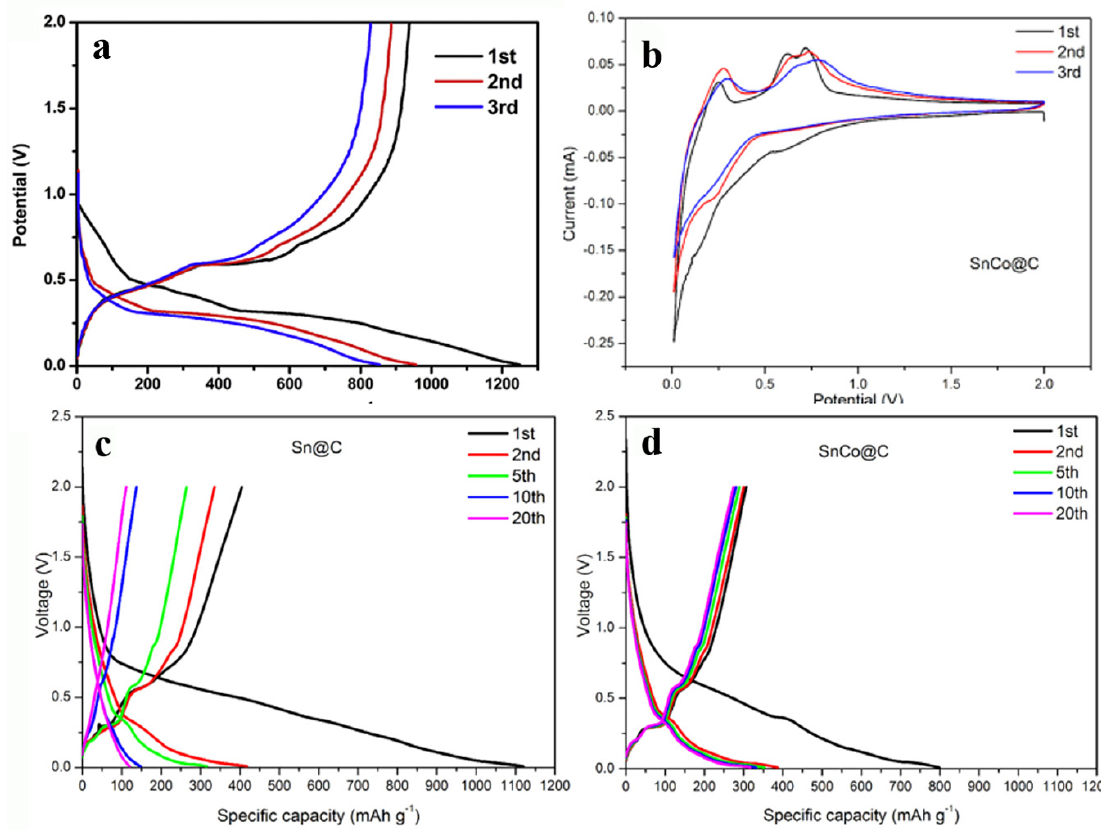
Figure 2. Li + and Na + storage in the Sn-Co alloy anode. ( a ) Charge-discharge profiles of Sn-Co@polymethyl methacrylate (PMMA) for the initial three cycles in lithium ion batteries (LIBs) [40]. ( b ) Cyclic voltammetry (CV) curves of SnCo@C in sodium ion batteries (SIBs) for the initial three cycles [41]. ( c ) and ( d ) Charge-discharge curves of Sn@C and SnCo@C at different cycles in SIBs, respectively [41].